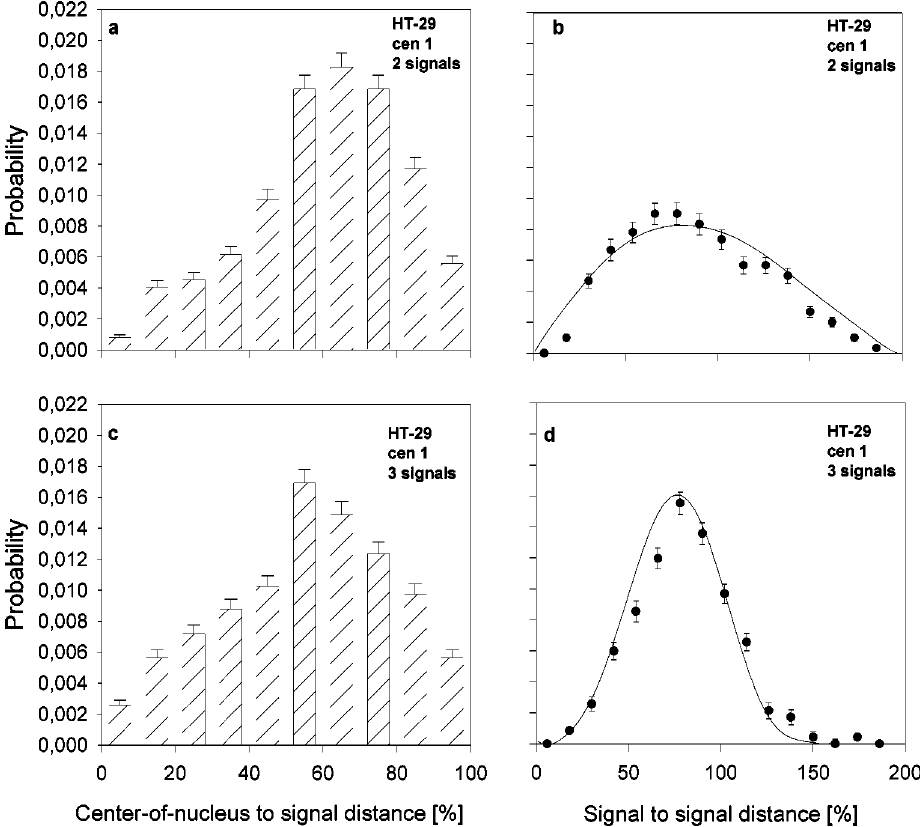
Fig. 5. Centre-of-nucleus to centromere 1 (a, c) and centromere to centromere (b, d) distributions determined in nuclei of HT-29 cells with two (a, b) or three (c, d) chromosomes 1. Experimental results are compared with theoretical functions (full curves) obtained by Monte-Carlo simulations (see Materials and methods). The number of investigated cells was 800–1000 for each